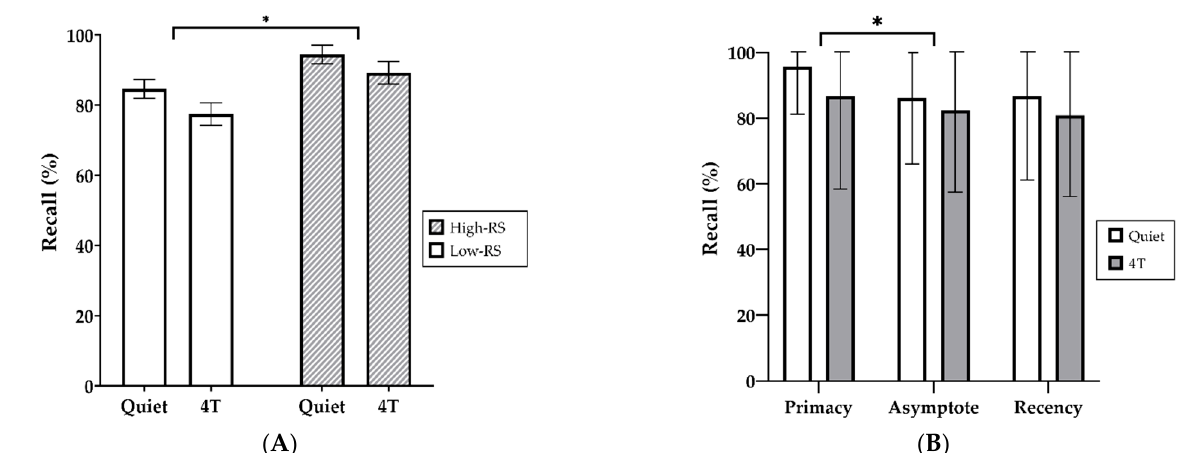
Figure 3. Results of Experiment 2. Mean recall percentages in the modified recall task of spoken words in quiet and four-talker babble ( A ) as a function of reading span (RS) group (low- and high-RS groups); ( B ) as a function of serial position (primacy, asymptote, and recency), * p < 0.0167.